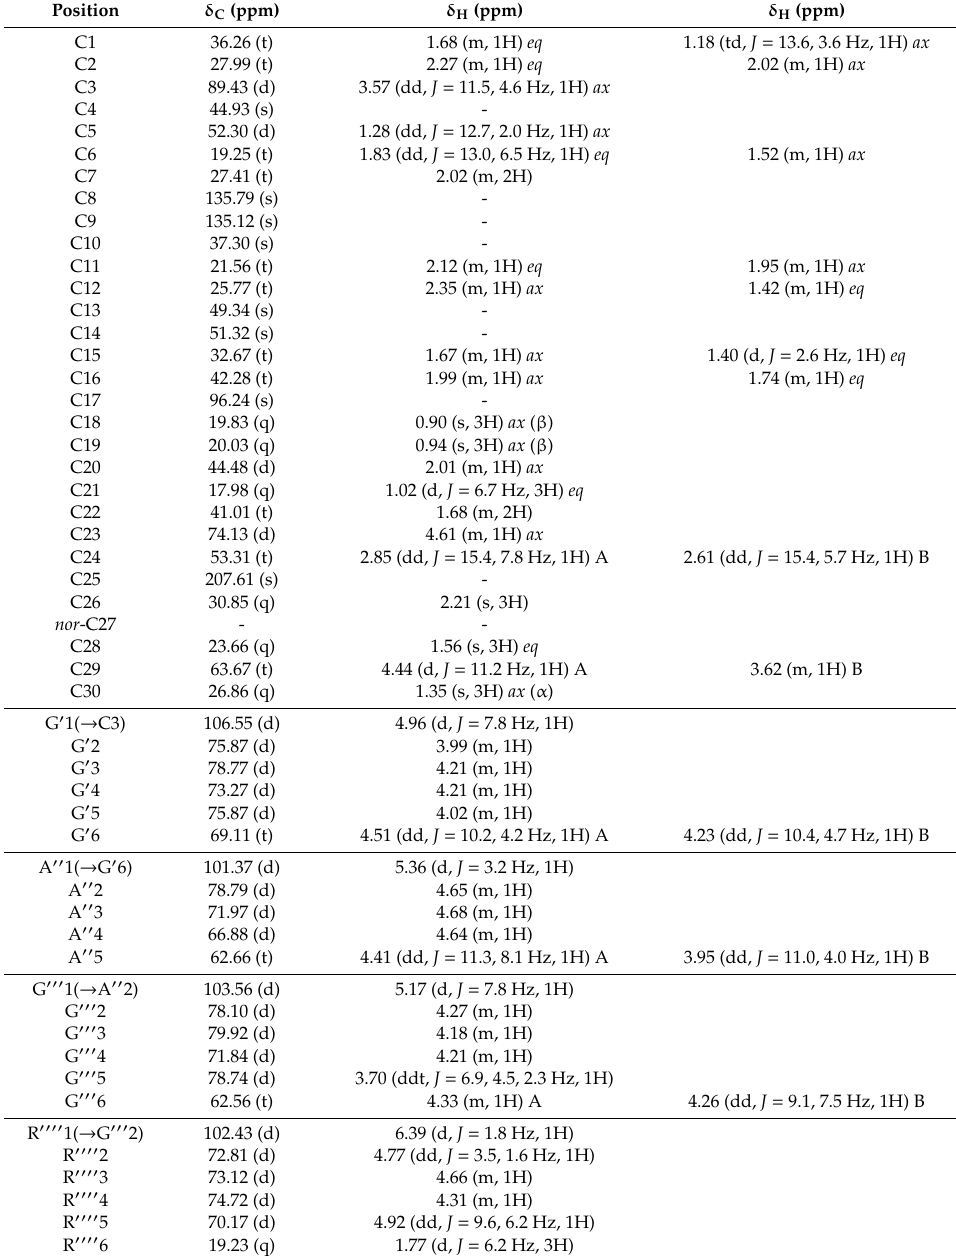
Table 2. 1 H-(600 MHz) and 13 C-(125 MHz) NMR chemical shifts of compound 13 (in pyridine- d5 ).